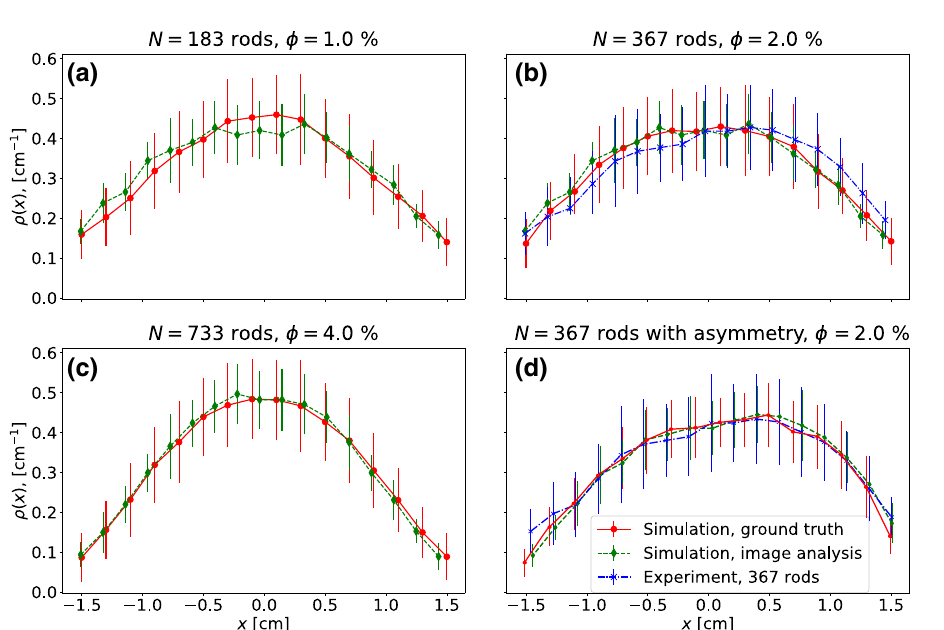
Figure 3. Normalized density profiles from a simulation of ( a ) 183, ( b ) 367 and ( c ) 733 rods, ground truth compared to the profile obtained using the shadow density analysis from both front and bottom perspective views. A density profile obtained with the same method from the experimental videos for 367 rods is shown in ( d ). Results are averaged over 100 periods in the simulation and 50 periods in the experiment, for the middle 40 mm ), moving outward (corresponds to frame number 45 in Fig. position of the pistons ( L = numbers) runs from bottom to top. We compare the ground truth density profiles (Fig. 4a) with the ones obtained from the analysis of synthetic images (Fig. 4b), and with the result of the analysis of experimental video footage (Fig. 4c) for the 6th parabola of day 1, ESA PFC71. All three space-time plots show satisfactory agreement. The largest discrepancy is observed around frame numbers 20–40, where the influx of the particles from the vibrating